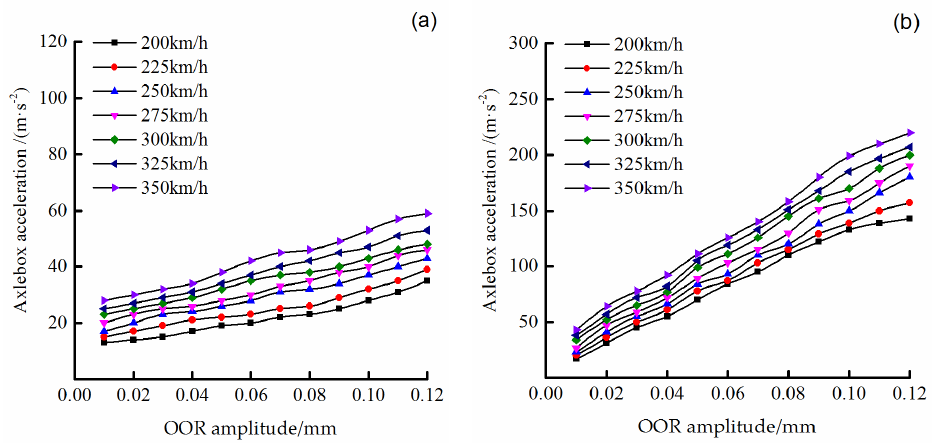
Figure 5. Vertical axle-box acceleration as a function of OOR amplitude at different speeds for ( a ) a 4th-order polygonized wheel and ( b ) a 24th-order polygonized wheel.